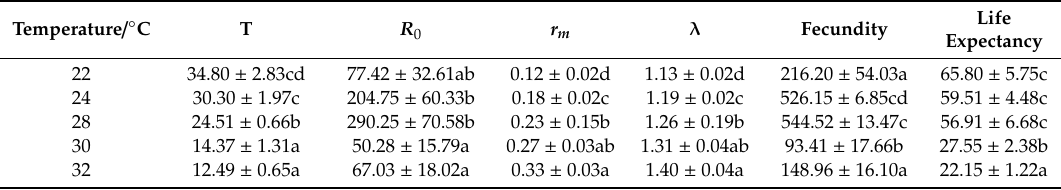
Table 2. Population parameters of C. malaccensis at different temperatures.